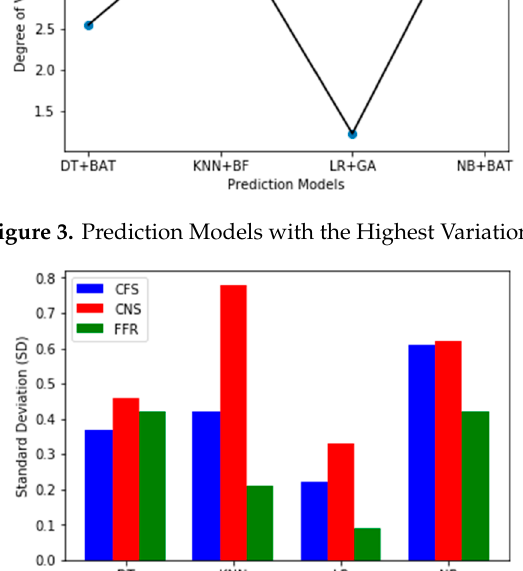
Figure 4. Performance Stability of Prediction Models (SD).